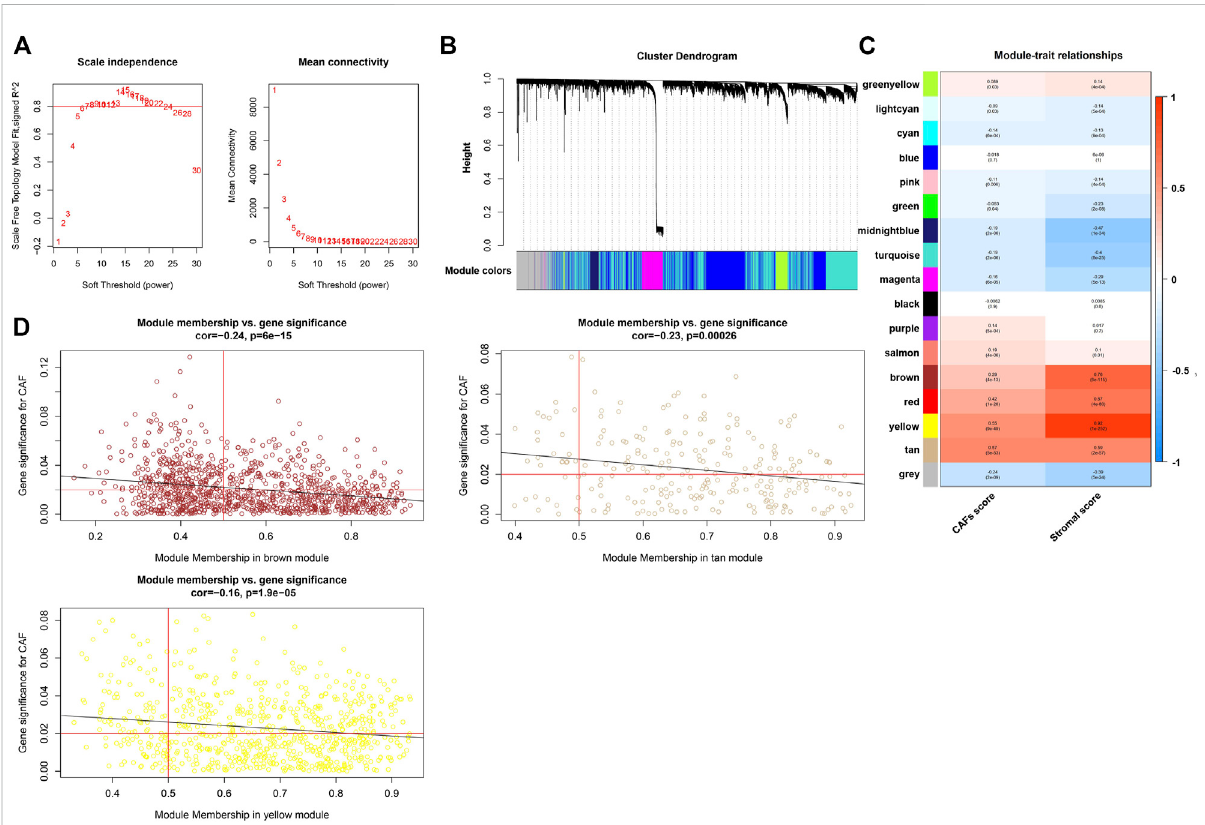
FIGURE 4 WGCNA and the identi fi cation of CAFs-related hub module. (A) Analysis of the scale-free ft index for various soft-threshold powers ( β ) and the mean connectivity for various soft-threshold powers. (B) Clustering dendrogram of all genes with dissimilarity based on topological overlap and assigned module colors. (C) The correlation between modules and traits were displayed. (D) The correlation between GS and MM in the brown, yellow, and tan